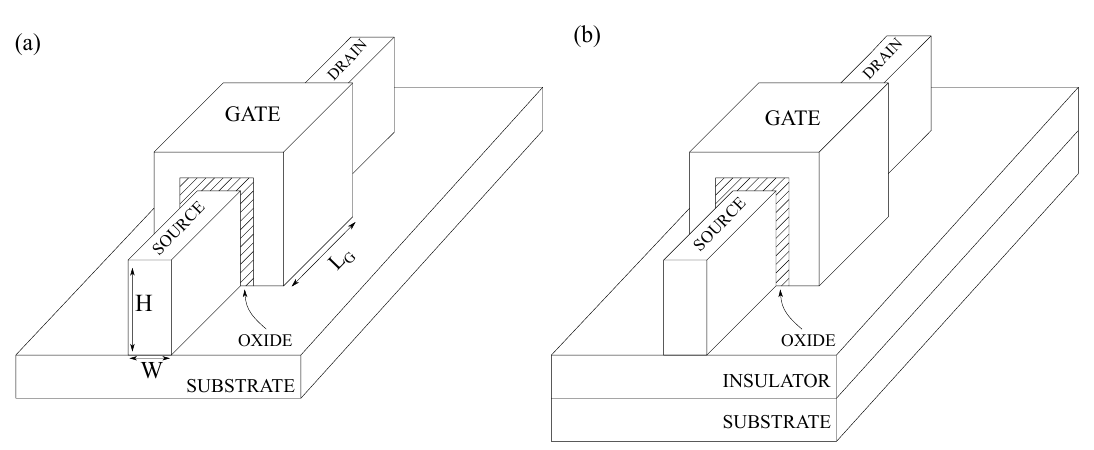
Figure 8. 3D FinFET structure: ( a ) bulk, ( b ) SOI.